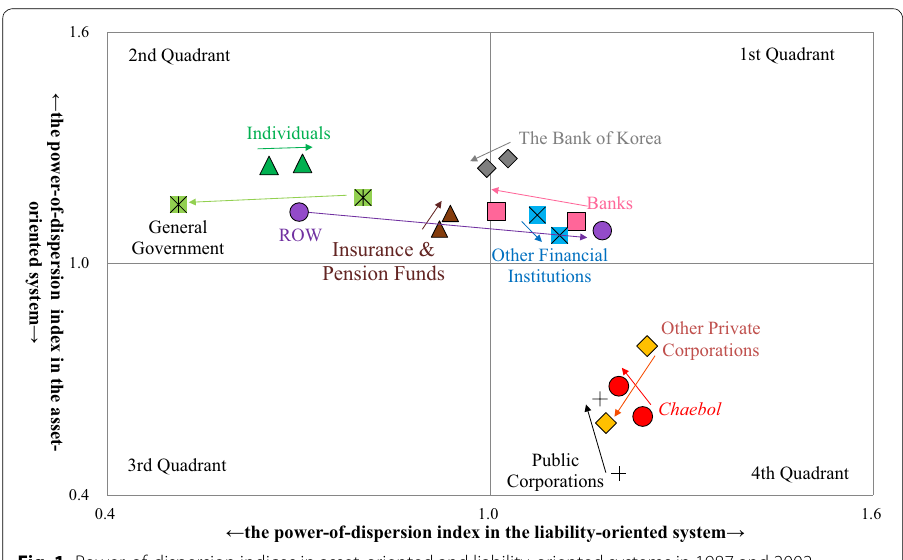
Fig. 1 Power-of-dispersion indices in asset-oriented and liability-oriented systems in 1987 and 2002